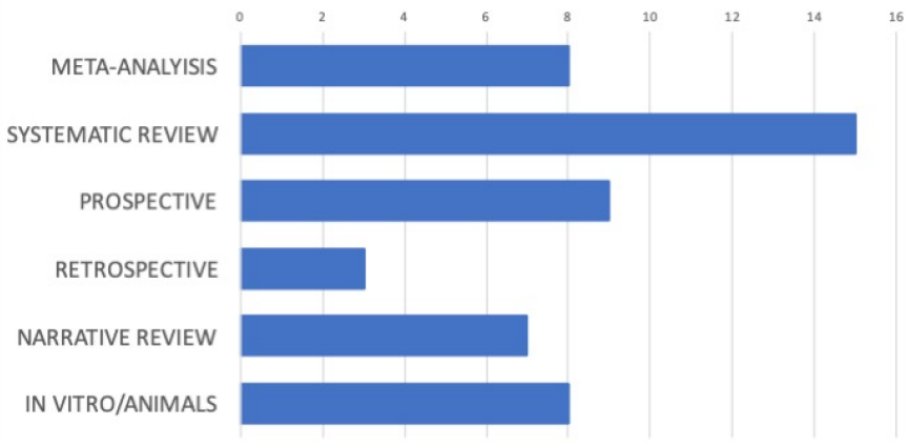
Figure 2. Design of the selected papers.